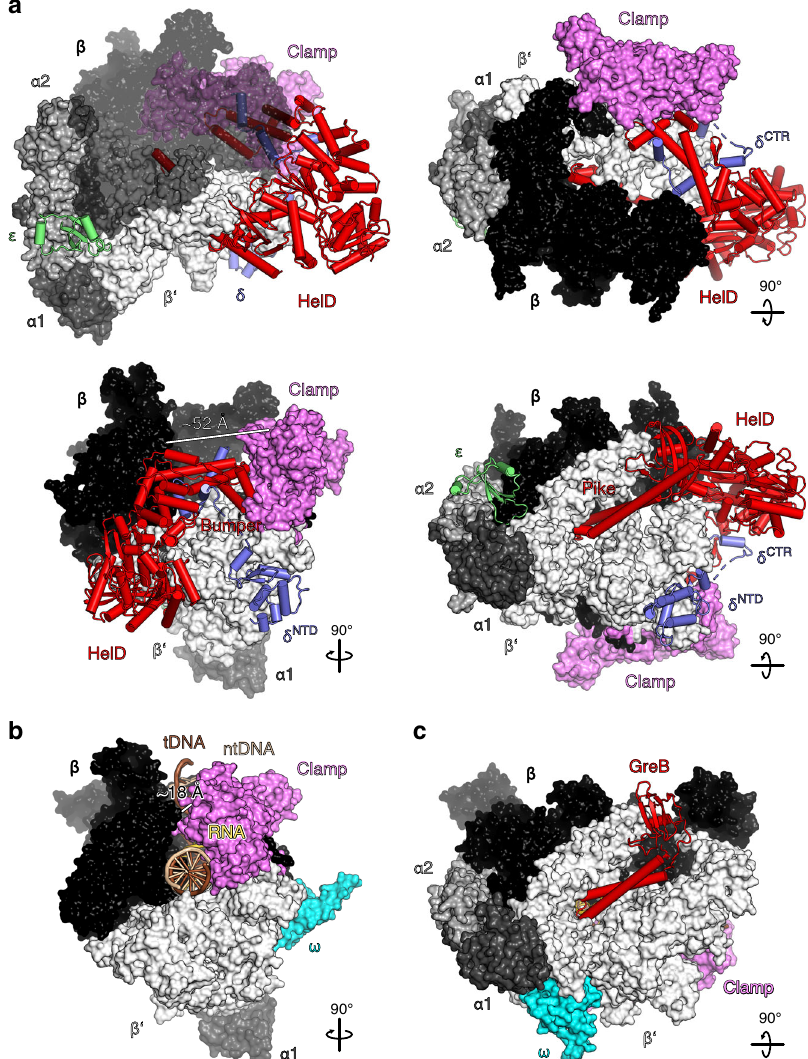
Fig. 1 Structural overview. a Overall architecture of an RNAP- δ -HelD complex. β surface is semi-transparent in the upper left panel. Rotation symbols in this and all fi gures indicate views relative to the upper left panel. Color coding in all fi gures, unless otherwise noted: α 1, dark gray; α 2, gray; β , black; β ′ , light gray; β ′ clamp, violet; ε , lime green; δ , slate blue; HelD, red. b Comparison to an E. coli EC (PDB ID 6ALH), illustrating marked widening of the main channel in RNAP- δ -HelD. ω , cyan; template (t) DNA, brown; non-template (nt) DNA, beige; RNA, gold. c Comparison to an E. coli GreB-modi fi ed EC (PDB ID 6RIN), illustrating similar secondary channel invasion by coiled-coil elements in GreB and